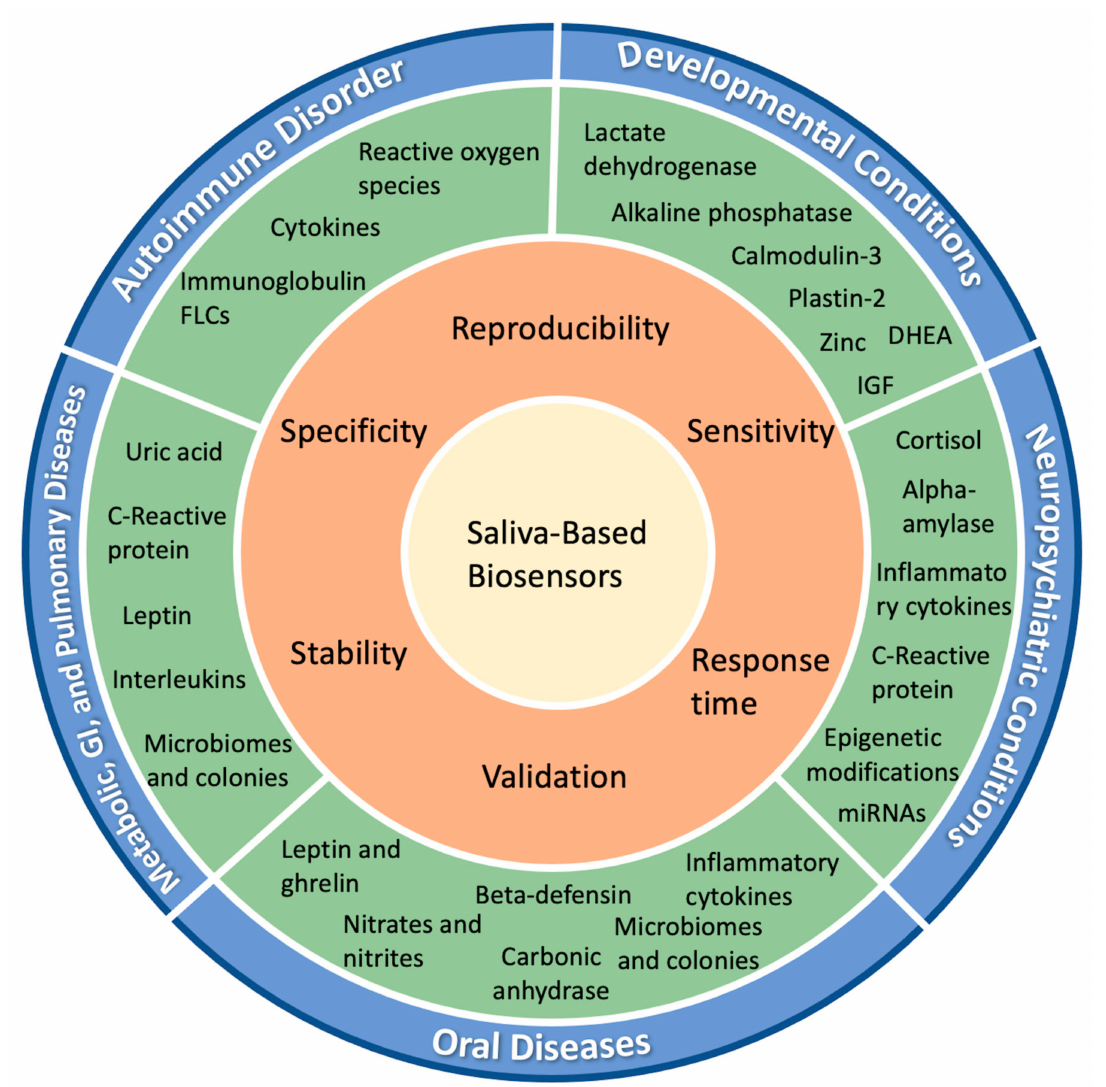
Figure 1. Prospects for saliva-based biosensors: various biomarkers have been identified in systemic conditions; discussed here are autoimmune disorders, developmental conditions, neuropsychiatric conditions, metabolic disorders, gastrointestinal disorders, pulmonary diseases, and oral diseases. For biosensing applications, they should be assessed for: their reproducibility at different time points, locations, and populations; specificity towards the marker and disease; sensitivity, meaning they should be able to detect as low a concentration of the markers as possible, ideally lower than a clinically available test; the response time of the assay, preferably shorter for quicker results; and validation in clinical conditions in larger population